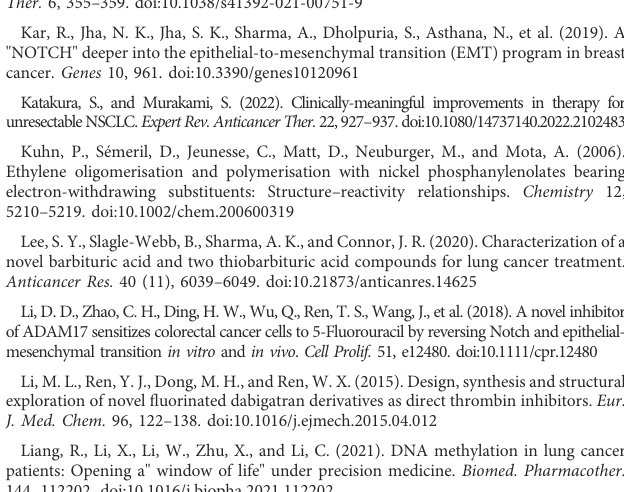
SUPPLEMENTARY FIGURE S1 Determination of the purity of the compounds (A) ZLDI-8 and (B) NY-2. SUPPLEMENTARY FIGURE S2 Total antioxidant capacity of ZLDI-8 and NY-2. SUPPLEMENTARY FIGURE S3 Comparison of the metabolic stability of ZLDI-8 and NY-2 (100 μ M) in rat liver microsomes (RLMs) and human liver microsomes (HLMs). SUPPLEMENTARY FIGURE S4 In vivo acute toxicity experiment of compound NY-2; the weight changes of mice within ten days. SUPPLEMENTARY FIGURE S5 Original western blots of compound NY-2. SUPPLEMENTARY TABLE S1 Summary results of pharmacokinetic